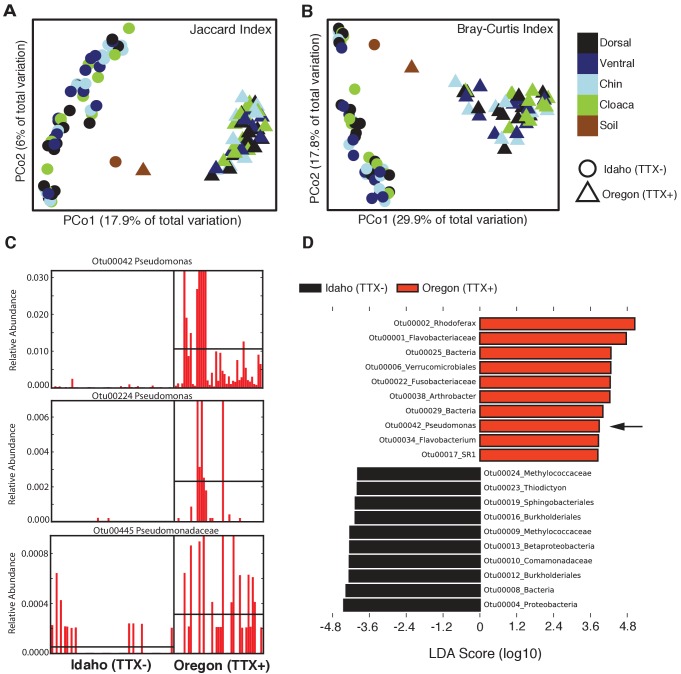
Comparison of skin microbiota from toxic and non-toxic newt populations reveal distinct host-associated bacterial communities and enrichment of TTX-producing bacteria.(A–B) Principal coordinates analysis of bacterial community composition (OTU presence/absence; Jaccard index) and community structure (OTU relative abundance; Bray-Curtis index) of skin microbiota across four body sites from toxic Oregon and non-toxic Idaho newts reveal distinct clustering of bacterial communities within each population. Non-parametric multivariate analysis of variance (PERMANOVA) test indicates a significant effect of location on both the composition (F = 18.12, p<0.0001) and structure (F = 40.40, p<0.0001) of skin-associated bacterial communities. Newt-associated communities also cluster separately from soil communities sampled from each location. (C) Representative comparison of highly abundant OTUs from individual toxic Oregon and non-toxic Idaho newt microbiota samples (on x-axis) reveals increased relative abundance of Pseudomonas OTUs in toxic newts. (D) Linear discriminant analysis effect size (LEfSE) comparing the top 10 differentially abundant OTUs between toxic and non-toxic newt microbiota indicates that Pseudomonas OTU00042 is highly enriched in toxic newt microbiota (black arrow). Pseudomonas isolated from newt skin produced TTX (Figure 3). Sample sizes were n = 12 and n = 16 for Oregon and Idaho newts, respectively.